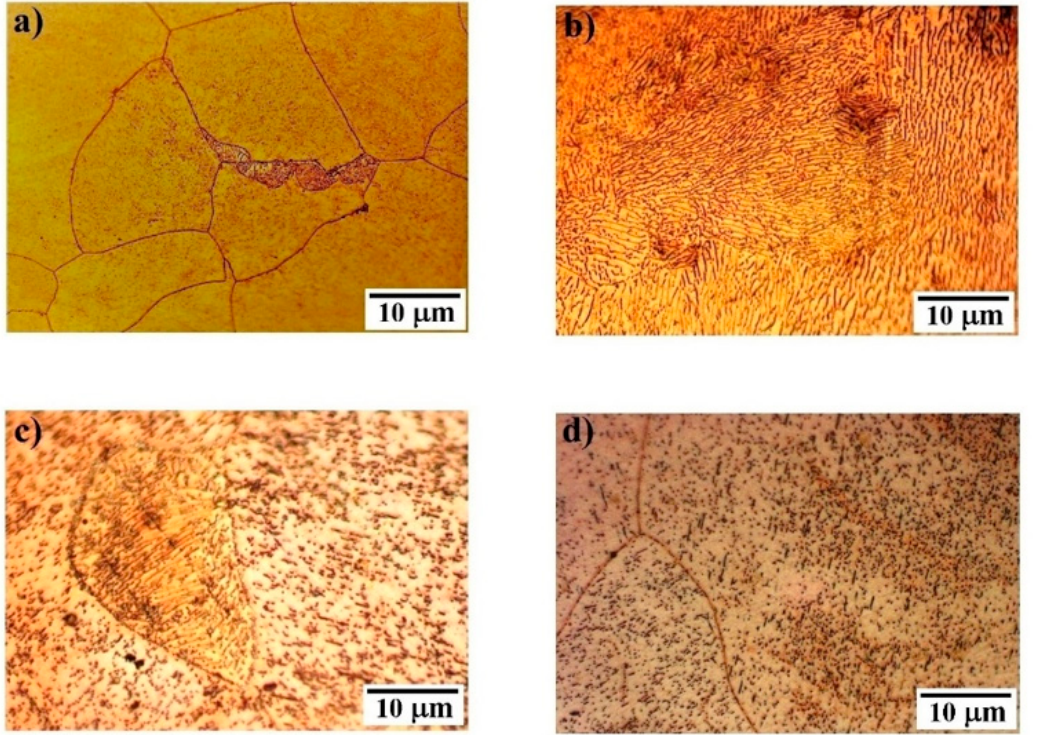
Figure 8. Optical micrographs of AZ91 alloy aged at 250 °C for a ) 4 h, b ) 12 h, c ) 96 h, and d ) 192 h.